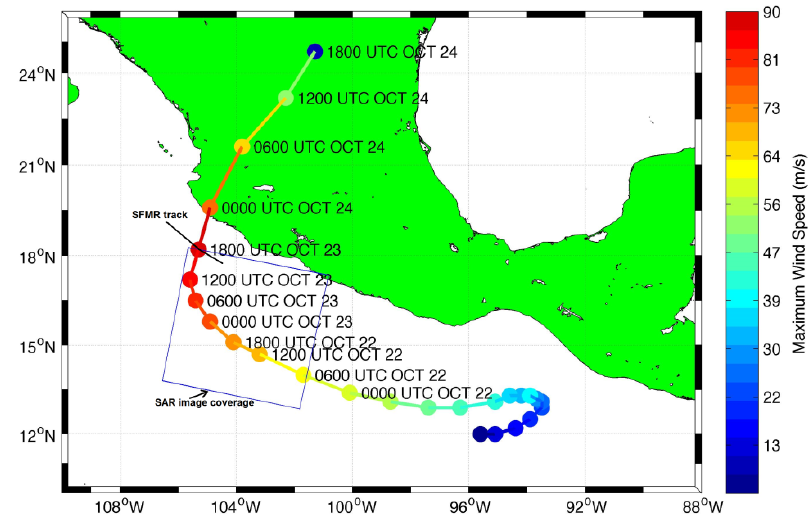
Figure 2. Track of Hurricane Patricia